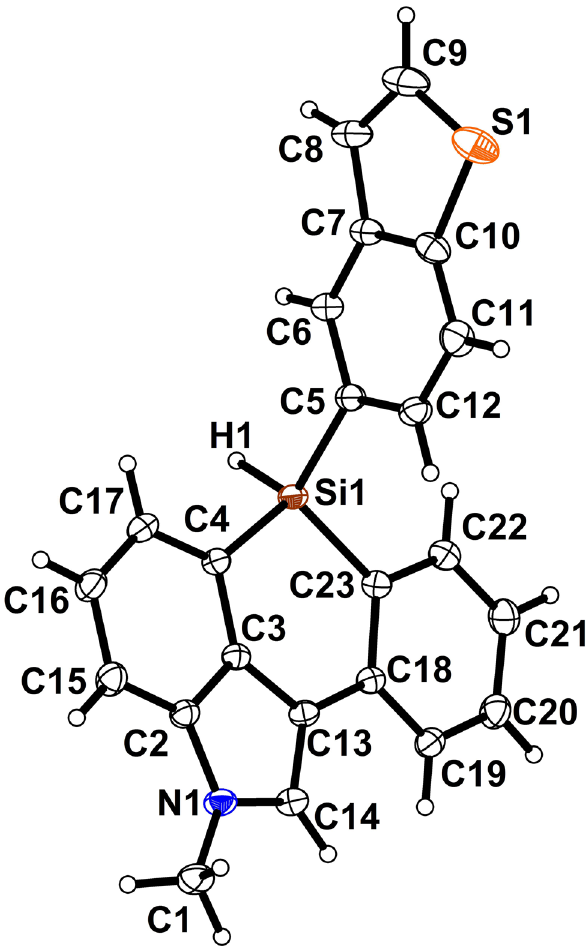
Table  : Data collection and